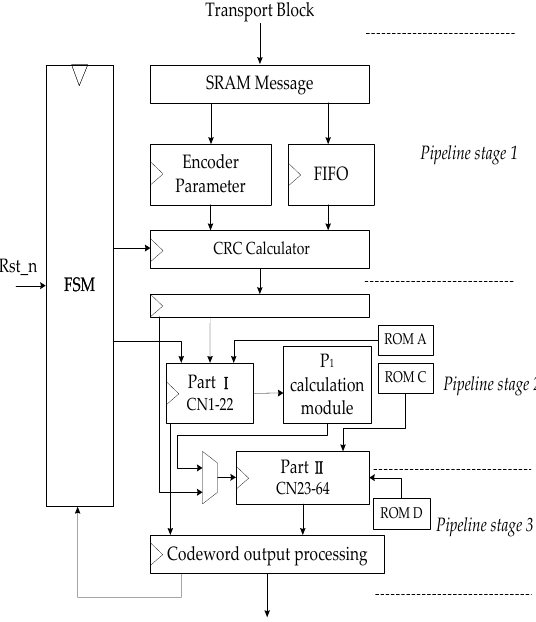
Figure 8. Pipeline of encoder hardware